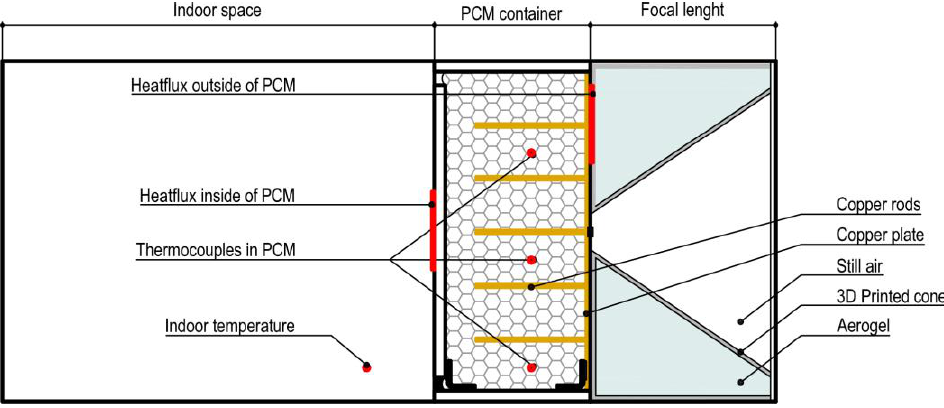
Fig. 5. Monitoring equipment